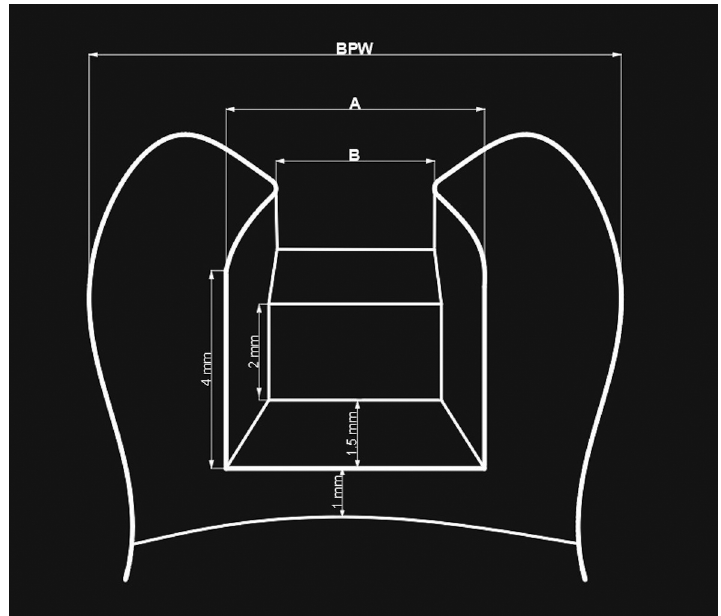
Figure 1- Schematic diagram of the MOD cavity design. Bucco-palatal width (BPW), gingival floor width (A= 2/3 BPW), occlusal isthmus width (B=1/2